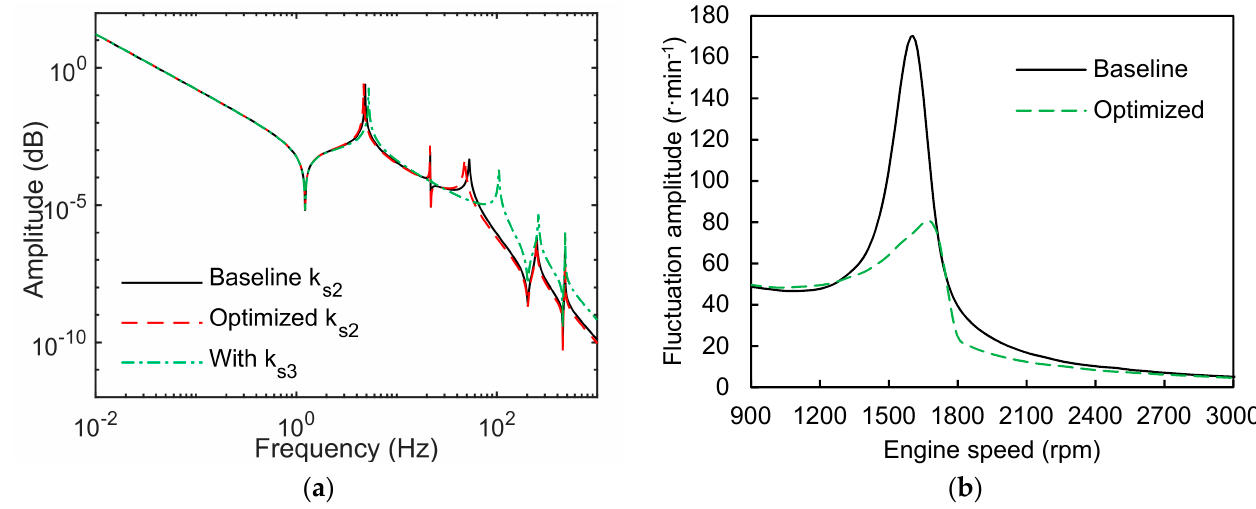
Figure 15. Calculated results of the optimized clutch. ( a ) Frequency response function of transmission; ( b ) the second − order speed fluctuation of transmission.